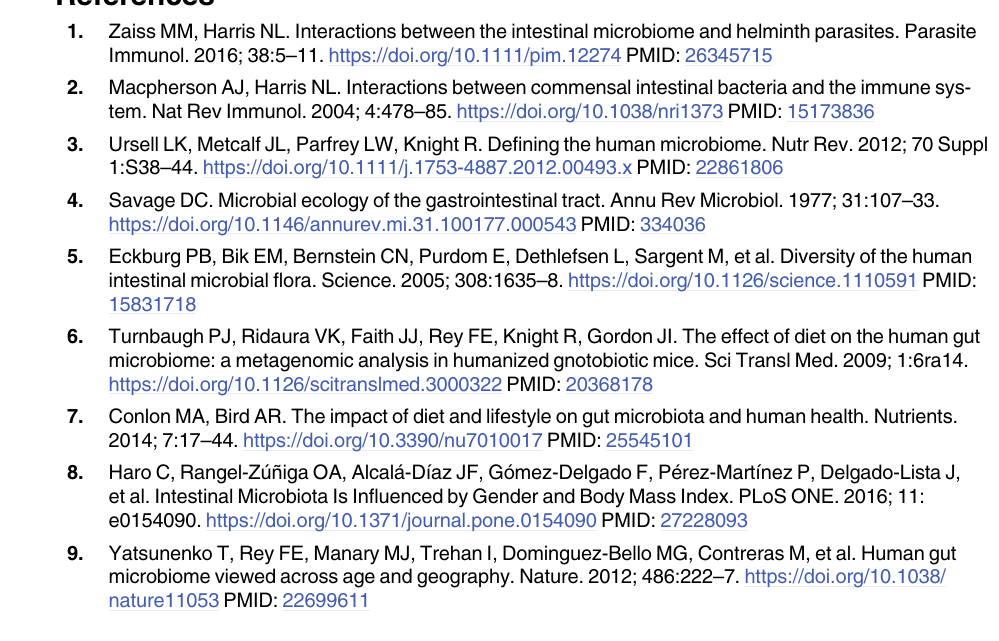
S1 Table. List of primers and probe sequences used in detecting the helminth species. S2 Table. The characteristics of participants of current study and total population in Nan-